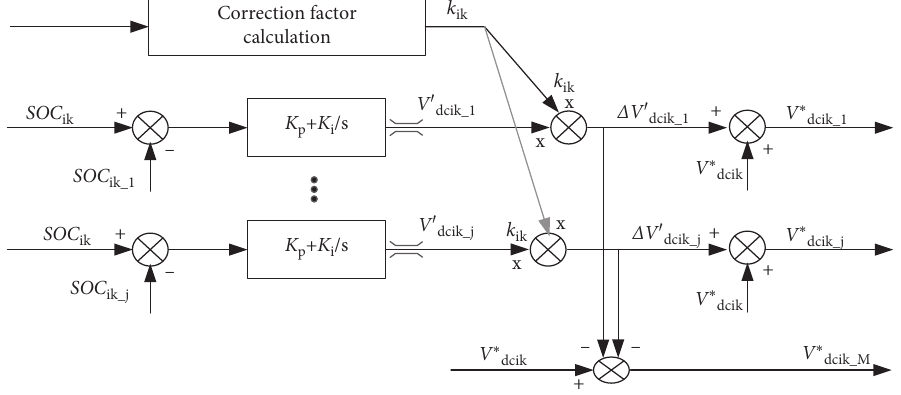
Figure 7: SOC equalization control strategy.